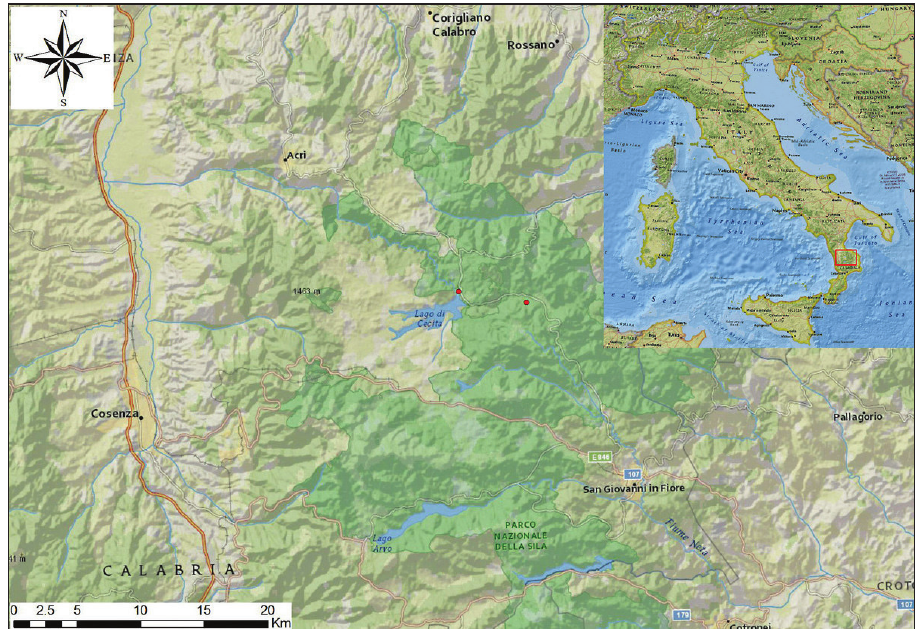
Figure 12. Geographic range and distribution map of Lathyrus laxiflorus subsp. laxiflorus in Italy. CRITERIA